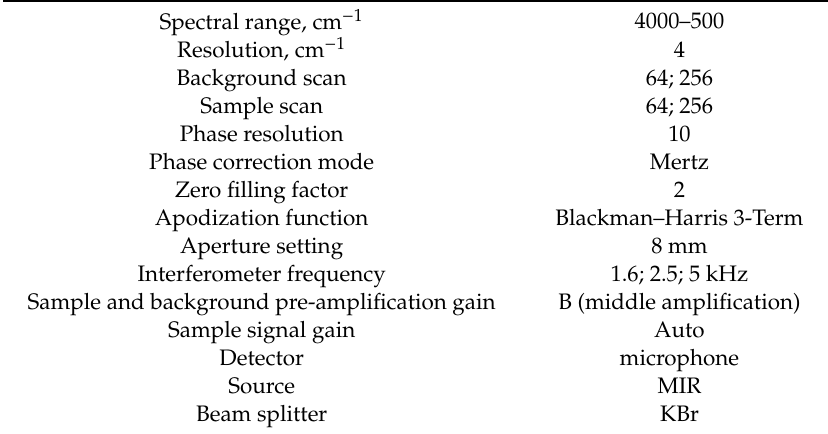
Table 2. Parameters of recording NDs spectra in the middle IR by FTIR–PAS.